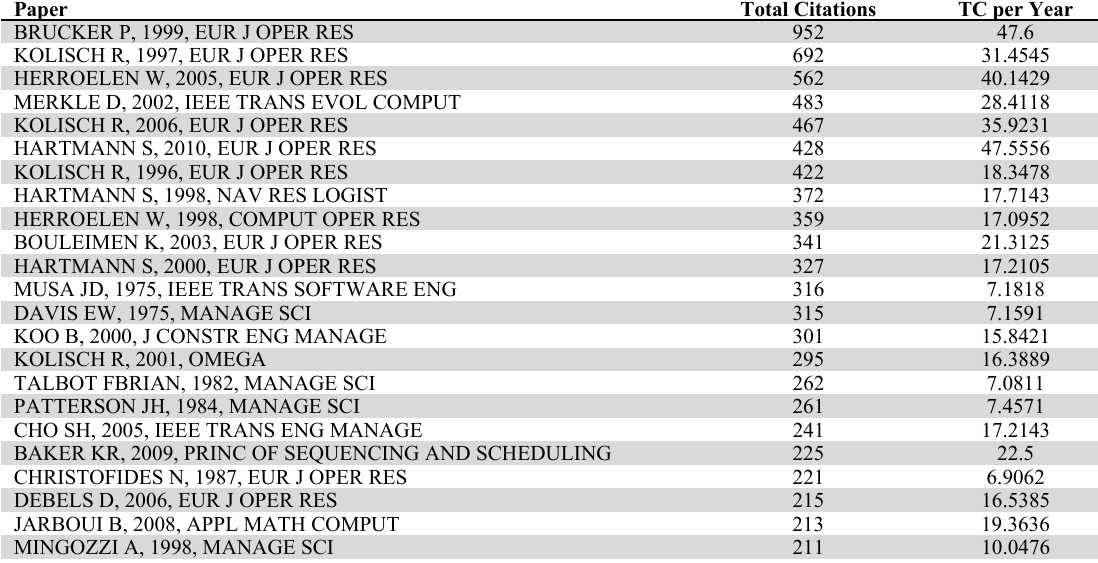
The summary of the most cited